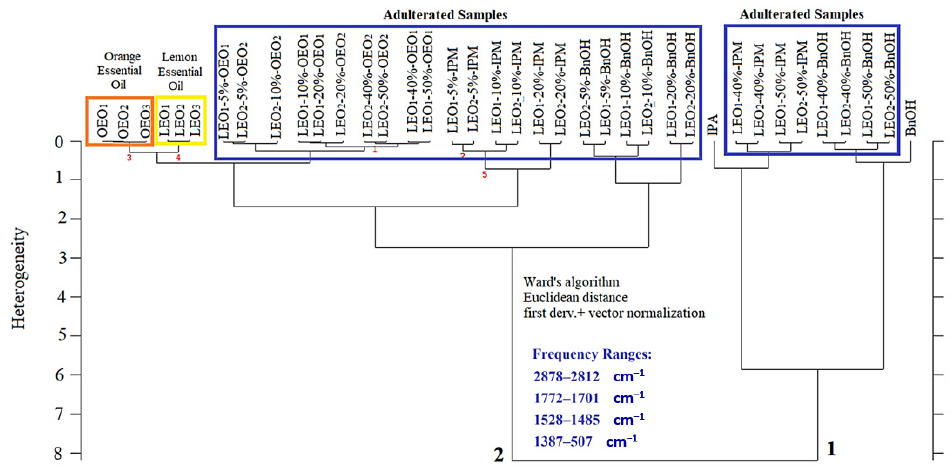
Figure 2. Two-dimensional hierarchical cluster analysis (HCA) plot of FTIR measurements from cold-pressed lemon essential oil, cold-pressed orange essential oil, adulterated samples, isopropyl myristate (IPM) and benzyl alcohol